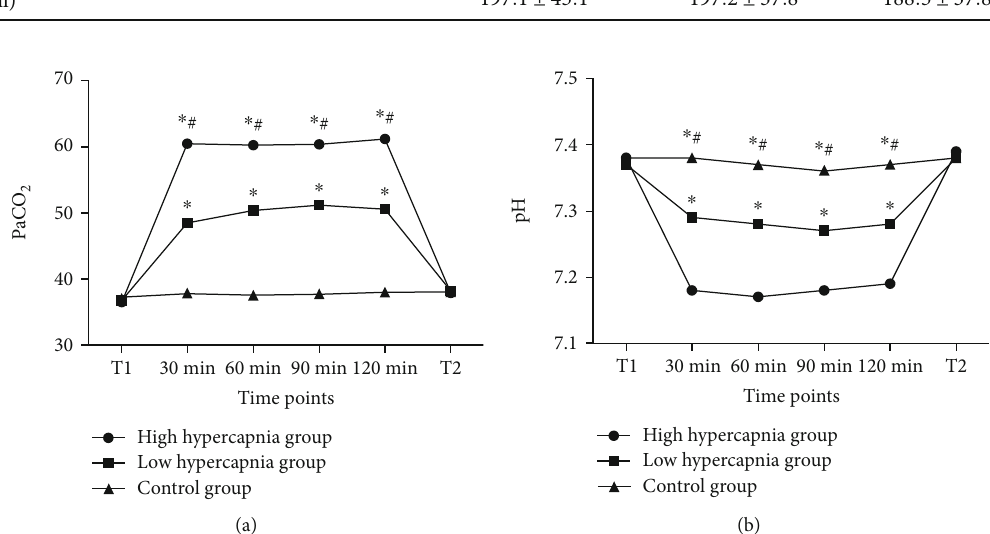
Figure 1: The ventilatory parameters during the pneumoperitoneum. The PaCO levels (a) were signi fi cantly higher in the high hypercapnia 2 group than in the low hypercapnia group and control group, whereas the pH values (b) were signi fi cantly lower in the high hypercapnia group. T1: before operation; T2: 30 min after pneumoperitoneum. ∗ Compared with control group; # compared with low hypercapnia